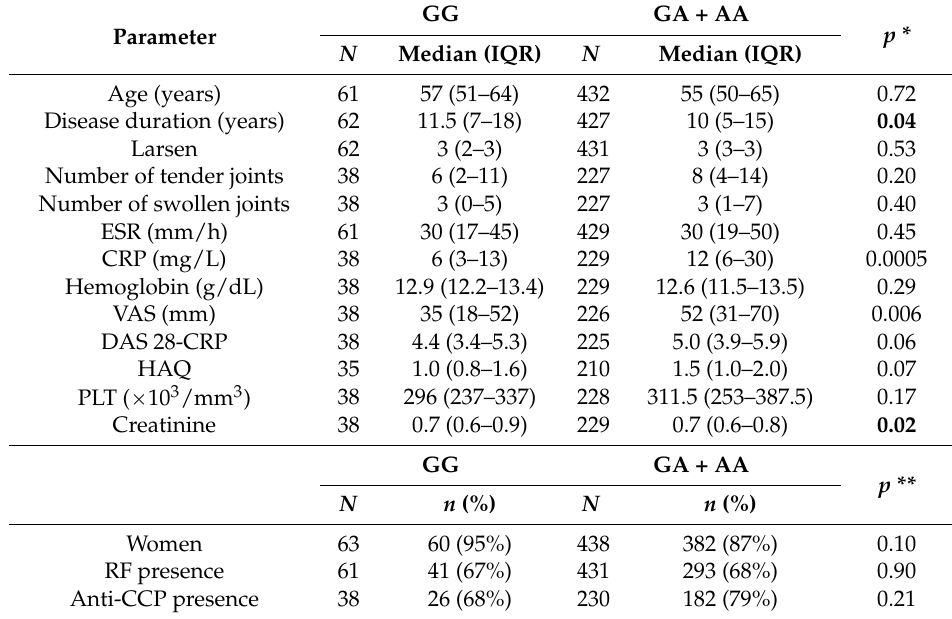
Table 5. The disease activity and laboratory parameters in relations to RORc4 rs9017 G/A; dominant model.